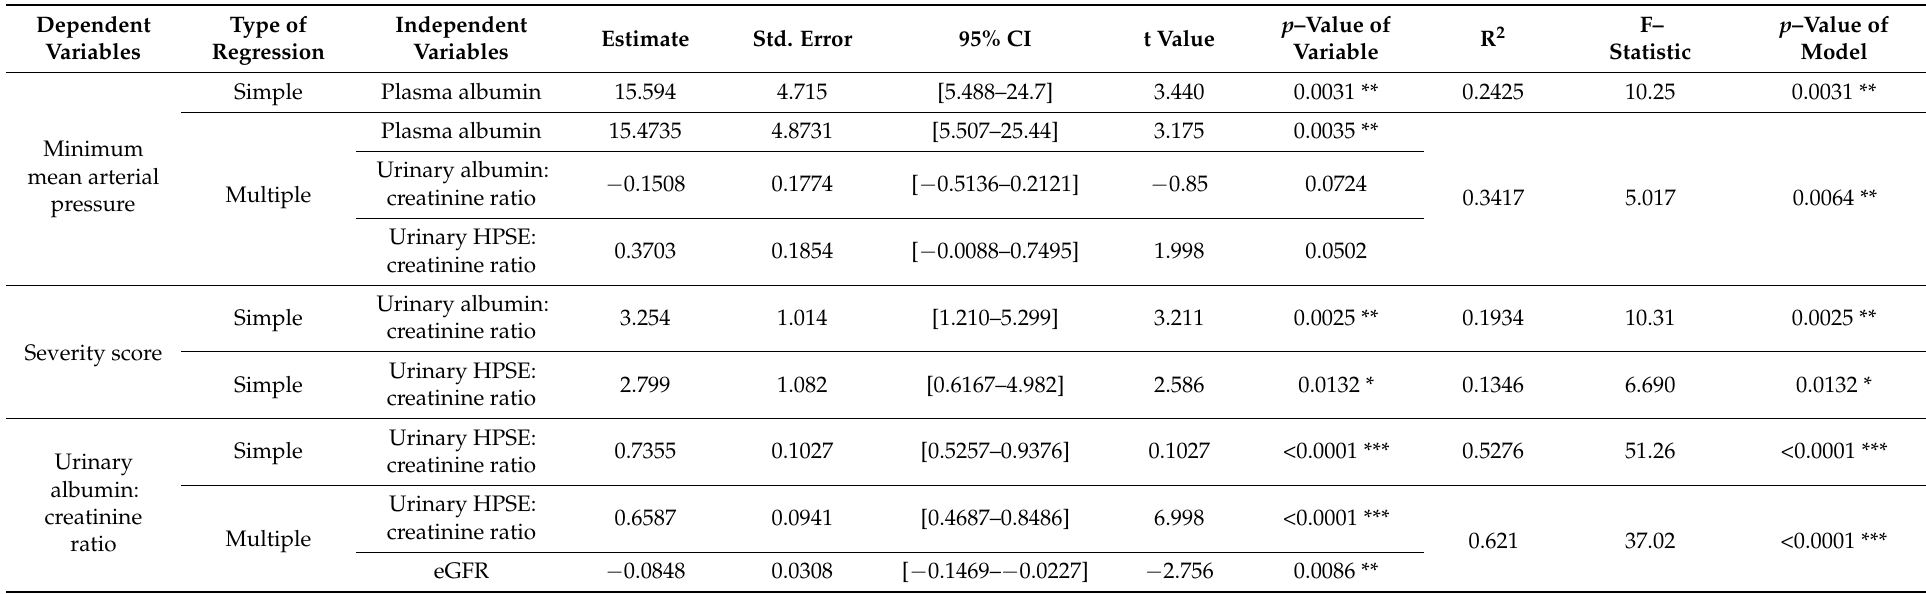
Table 2. Simple and multiple regression